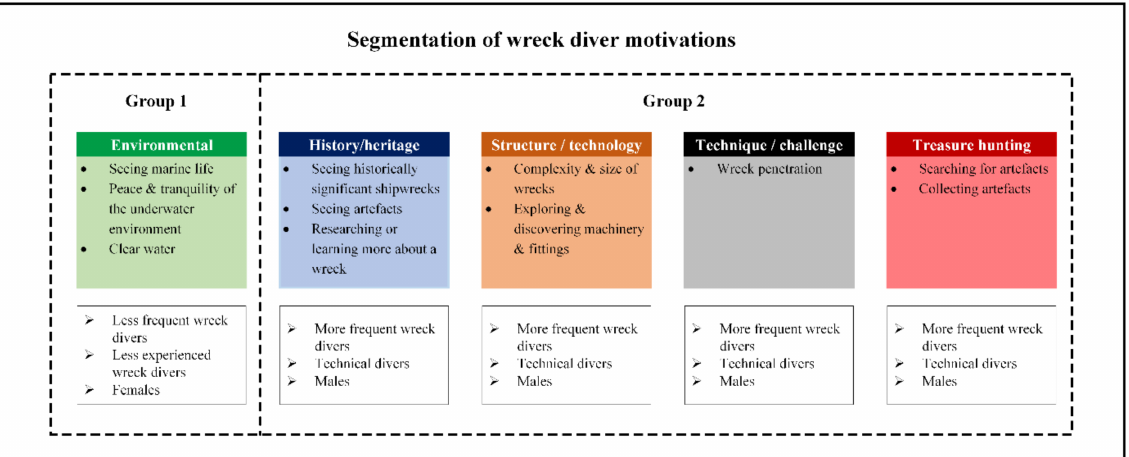
Figure 7. Segmentation of wreck diver motivations—adapted from [37] (p.